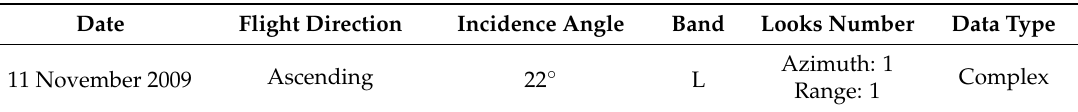
Table 1. Acquisition information about the Phased Array type L-band Synthetic Aperture Radar (PALSAR)